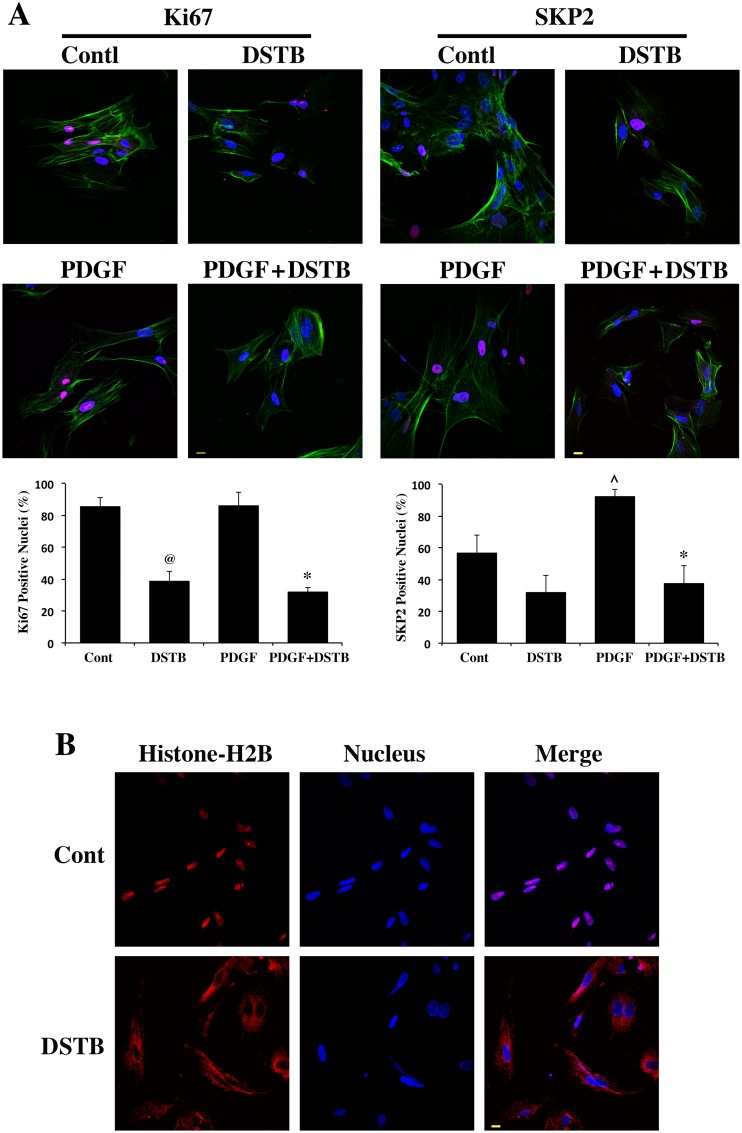
Dasatinib treatment suppresses nuclear localization of proliferation markers.(A) CFb were cultured on coverslips for 2 h. For dasatinib treatment, the drug (50 nM) was added to the cells 30 min prior to stimulation with ± PDGF (10 ng/ml). After 24 h treatment, cells were used for immunostaining. Left panels show immunostaining for Ki67 (red) and α-actinin (green) with specific antibodies and nuclear staining with DAPI (blue). Scale bar, 10 μm. Bottom graph: quantification of Ki67 positive nuclei was performed by counting over 50 nuclei (DAPI) in multiple sections from two independent experiments. The percentage of Ki67/DAPI is depicted in the graph. @p<0.05 vs. untreated control; *p<0.05 vs. PDGF. Right panels show immunostaining for SKP2 (red) and α-actinin (green) with specific antibodies and nuclear staining with DAPI (blue). Scale bar, 10 μm. Bottom graph: quantification of SKP2 positive nuclei was performed by counting over 50 nuclei (DAPI) in multiple sections from two independent experiments. The percentage of SKP2/DAPI is depicted in the graph. ^p<0.05 vs. untreated control; *p<0.05 vs. PDGF. (B) CFb were cultured on coverslips for 2 h in 10% FBS containg media and dasatinib (50 nM) or vehicle was then added. After 24 h dasatinib treatment, cells were immunostained for histone-H2B (red) with a specific antibody and nuclear stained with DAPI (blue). Scale bar, 10 μm.